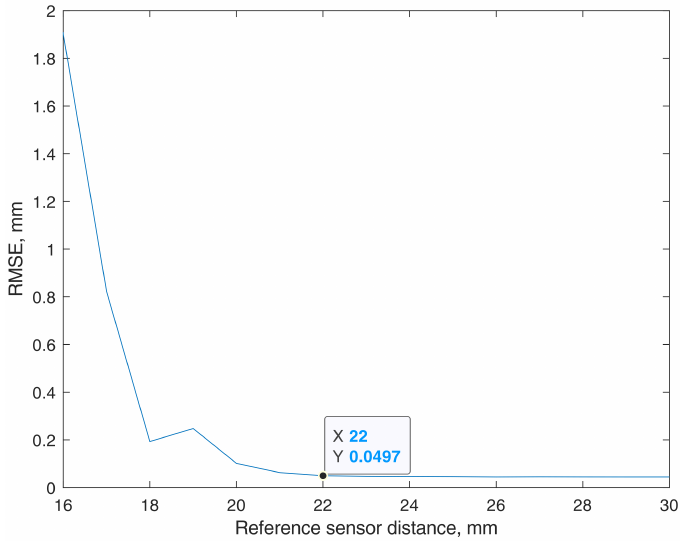
Figure 7. Dependency between the RMSE (Root mean square error) and reference sensor distance to the main sensor. Finite element model data.